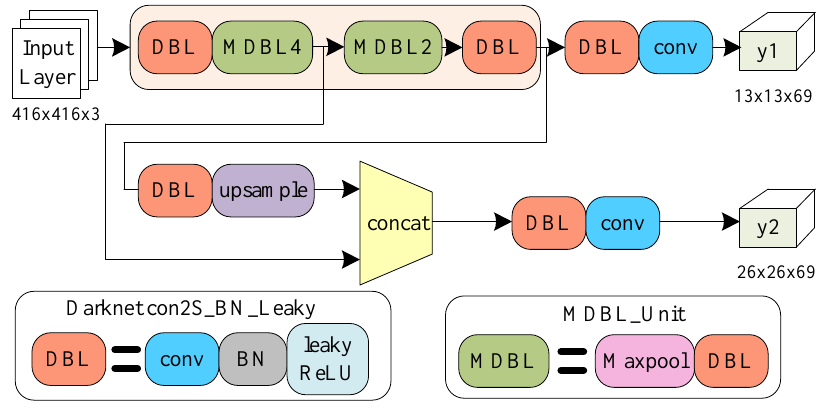
Figure 14. YOLOv3 structure diagram.